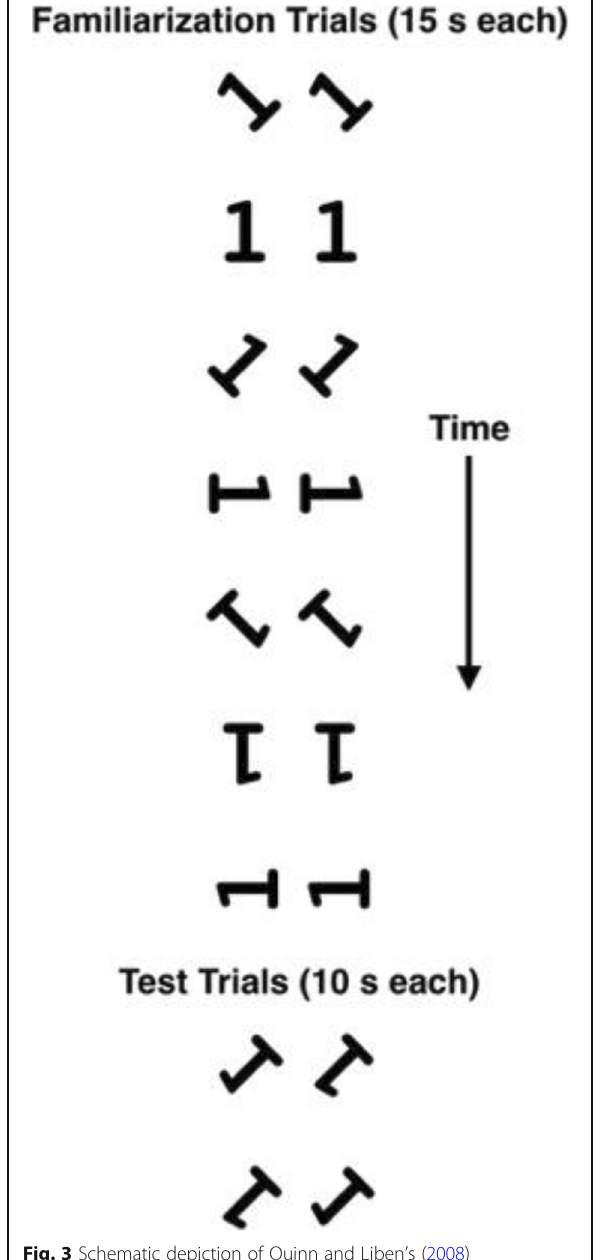
Fig. 3 Schematic depiction of Quinn and Liben ’ s (2008) experimental design. Infants were presented with seven different rotations of the number 1 stimulus (or its mirror image) during familiarization, with two identical copies of each stimulus presented on each trial. For familiarization, [Quinn & Liben] randomly selected seven of the eight possible rotations and their order of presentation for each infant in the female group and a corresponding infant in the male group. The test stimuli paired the novel rotation of the familiar stimulus with its mirror image ” (Quinn & Liben, p.